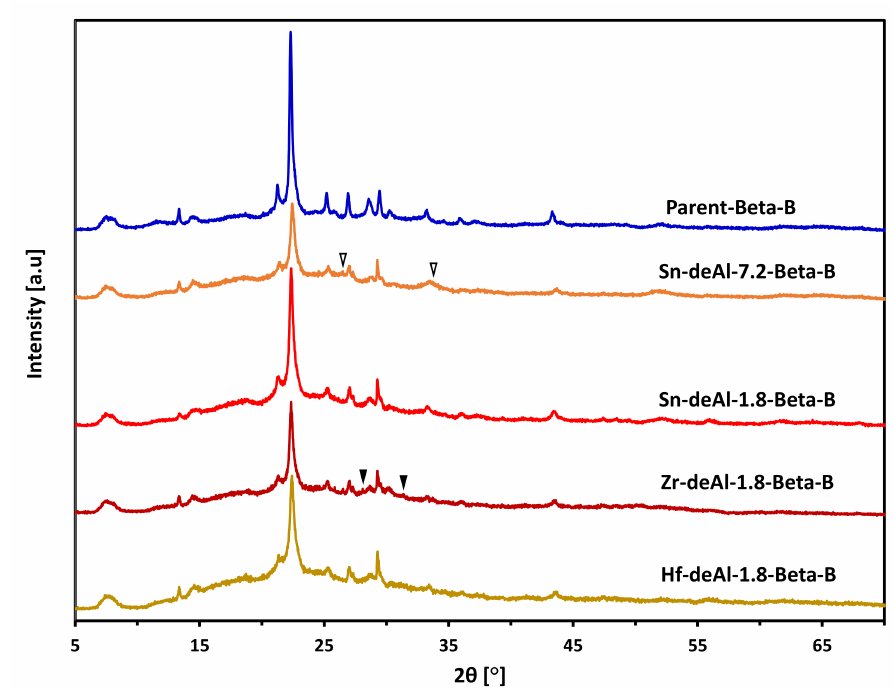
Figure 1. XRD patterns of the parent zeolite Beta beads and of the metal-containing Beta beads prepared by dealumination and following metal grafting; ( ∇ ) indicates signals from crystalline SnO 2 and ( (cid:72) ) indicates signals from crystalline ZrO 2 (magnified diffractograms highlighting the presence of these small amounts of metal oxides are provided in Figures S2 and S3). Table 1. Physicochemical properties of the parent zeolite Beta beads and of the bimetallic zeolite Beta beads.